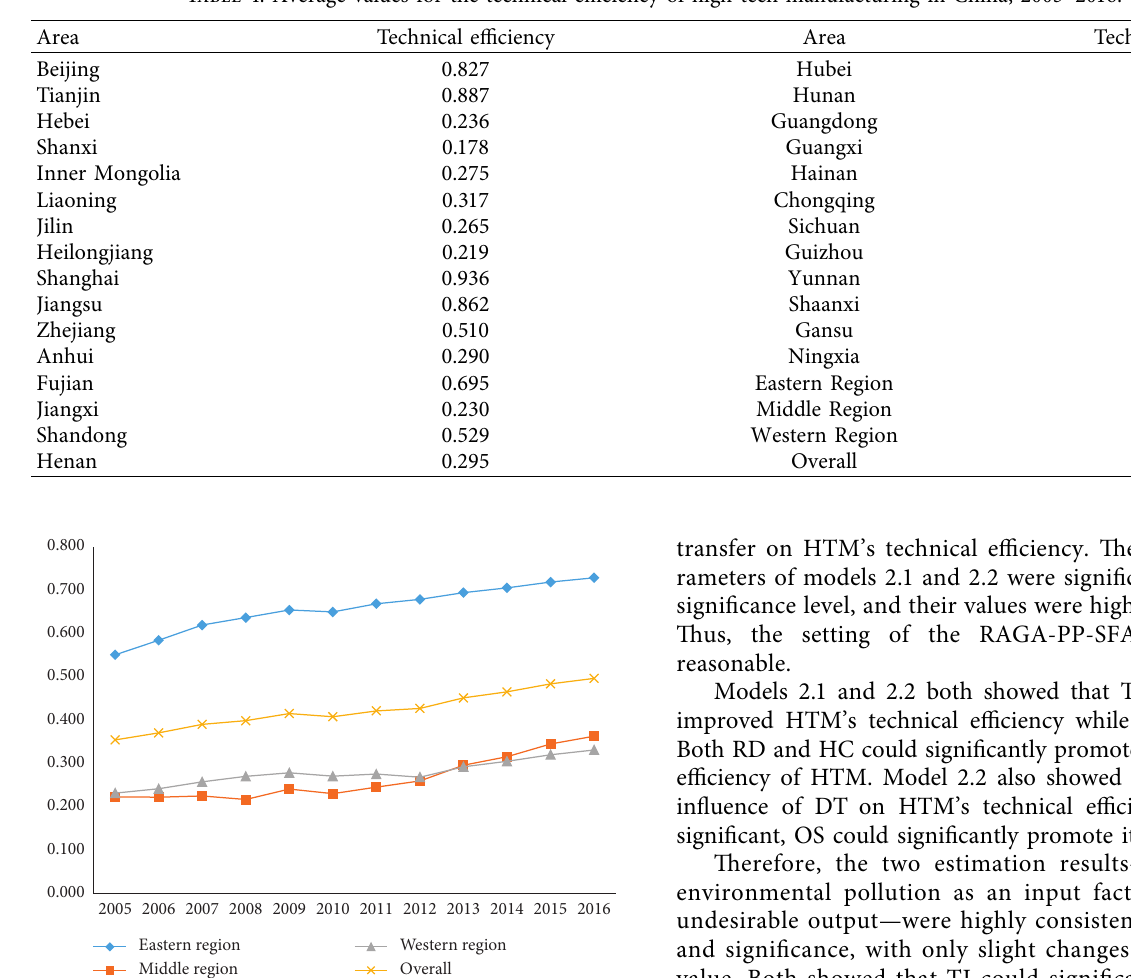
Figure 1: Regional differences in the technical efficiency of China’s high-tech manufacturing